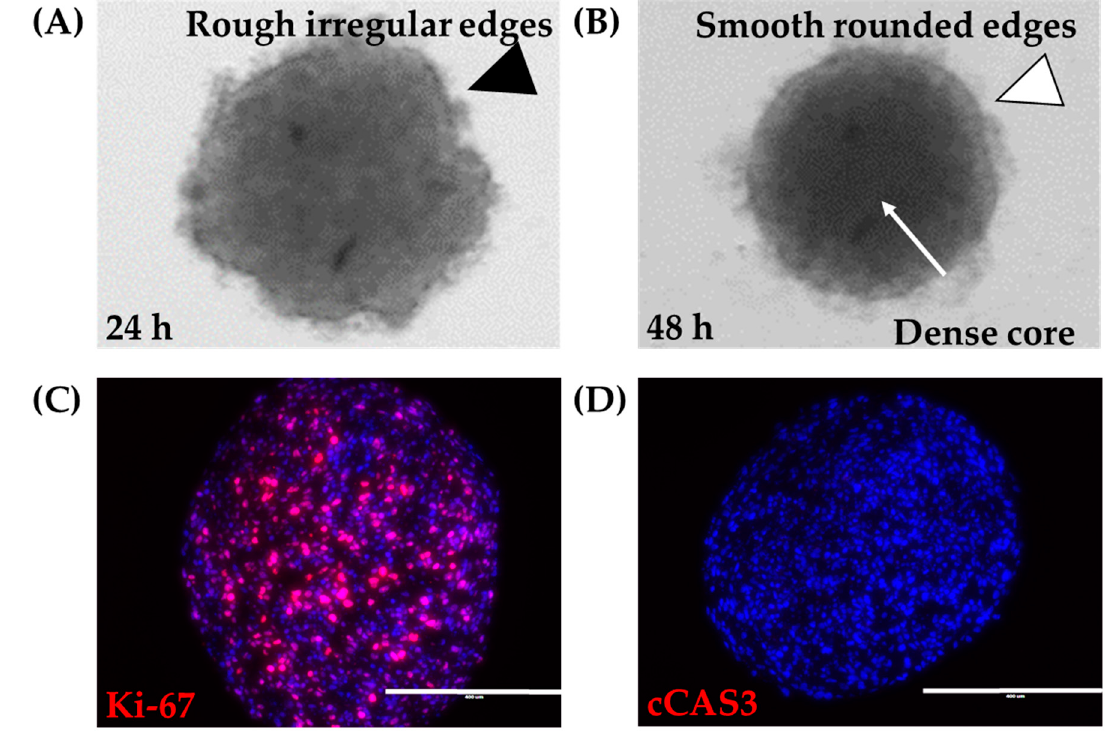
Figure 2. Large 12Z spheroids. ( A ) At 24 h, 18,000 12Z cells grown in ultra-low attachment round-bottom 96-well plates appear as a mass of cells with rough irregular edges (black arrowhead). ( B ) At 48 h, 12Z cells have formed a tight spheroid with a dense core (white arrow) and smooth rounded edges (white arrowhead). 12Z spheroids remain alive for at least 120 h, where the spheroids remained ( C ) proliferative (Ki-67, red) and ( D ) non-apoptotic (cCAS3, red). Blue = DAPI. Scale = 400 μ m.